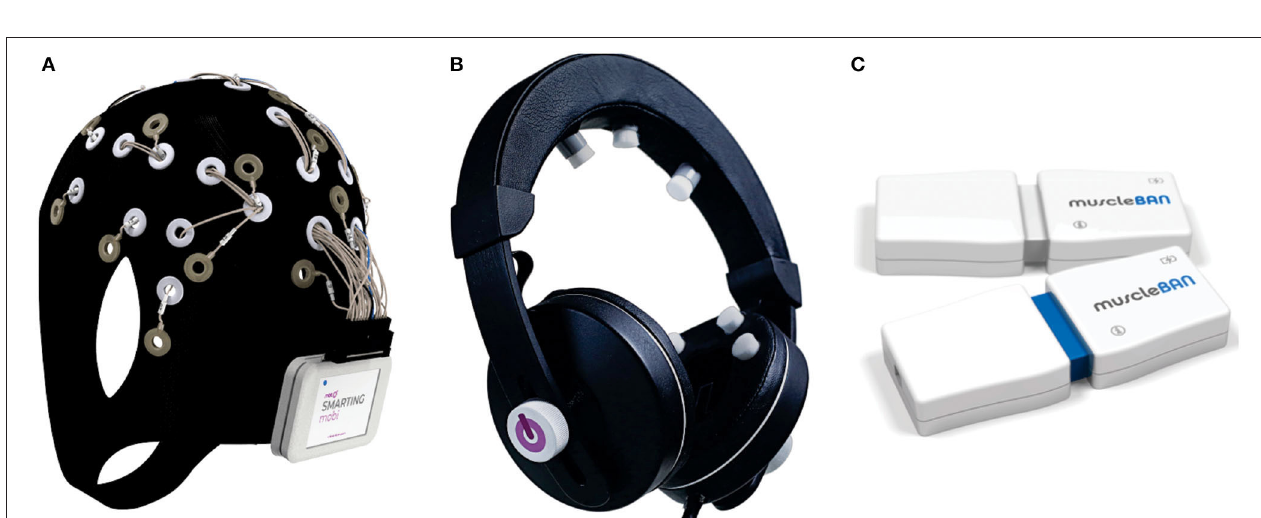
FIGURE 1 | (A,B) A laboratory model of industrial assembly workstation.